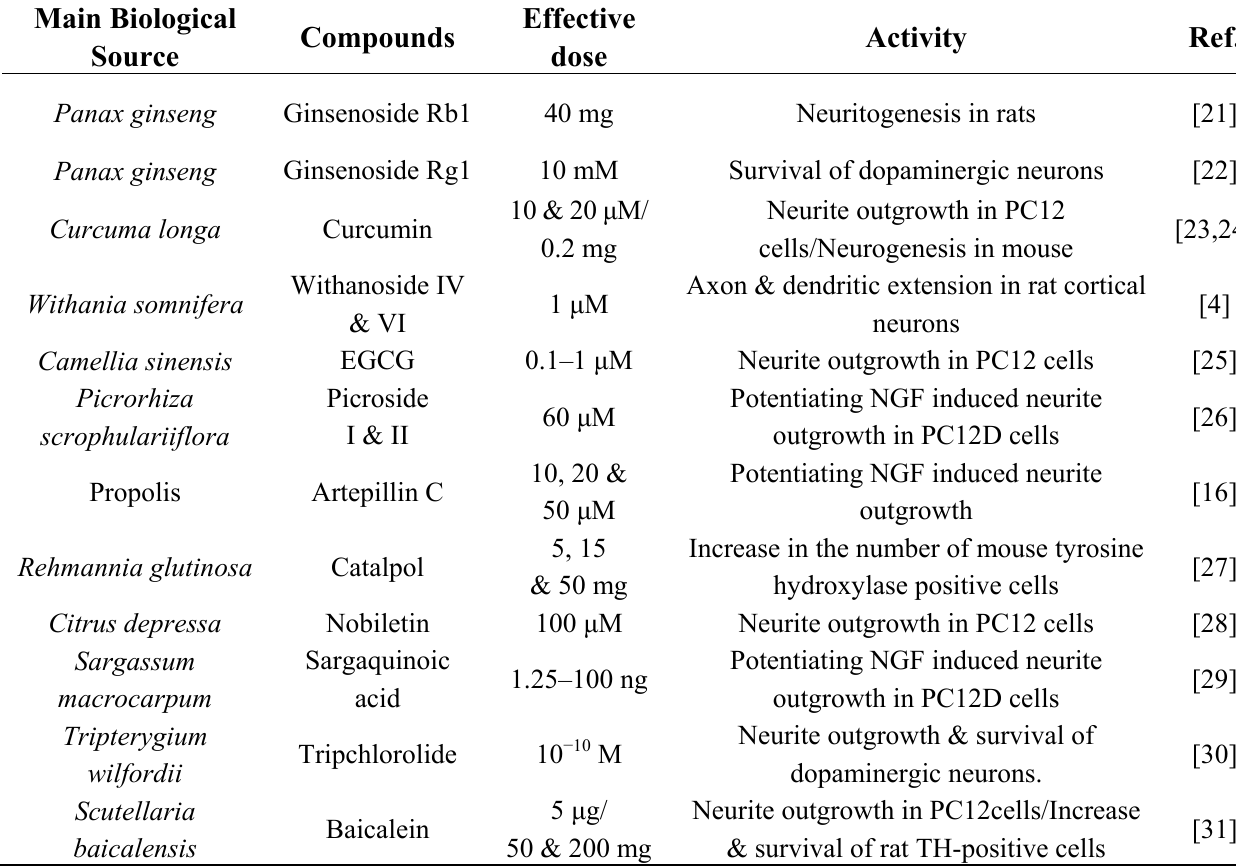
Table 1. Summary of selected compounds from natural sources exhibiting in vitro and in vivo neurite outgrowth activity.